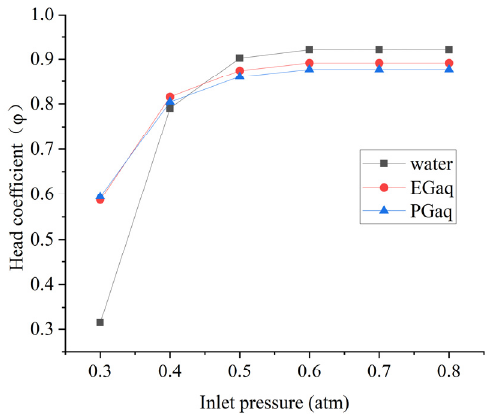
Figure 15. Cavitation curve of the pump with cylindrical blades at 60 °C.